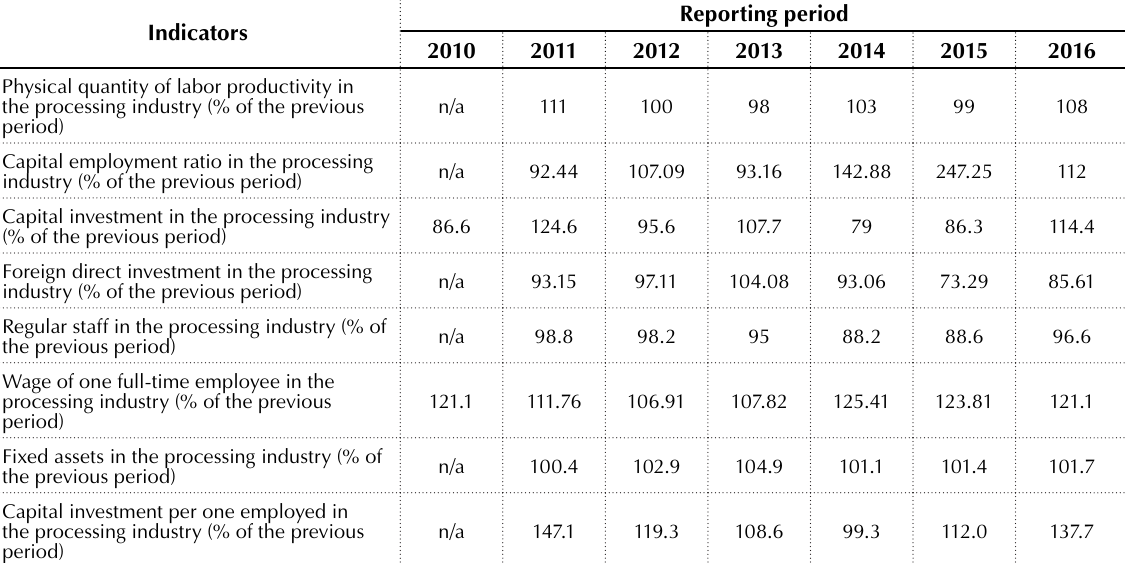
Table 3. Information base for modeling the volumes of new workplaces in the Ukrainian processing industry for 2010–2016